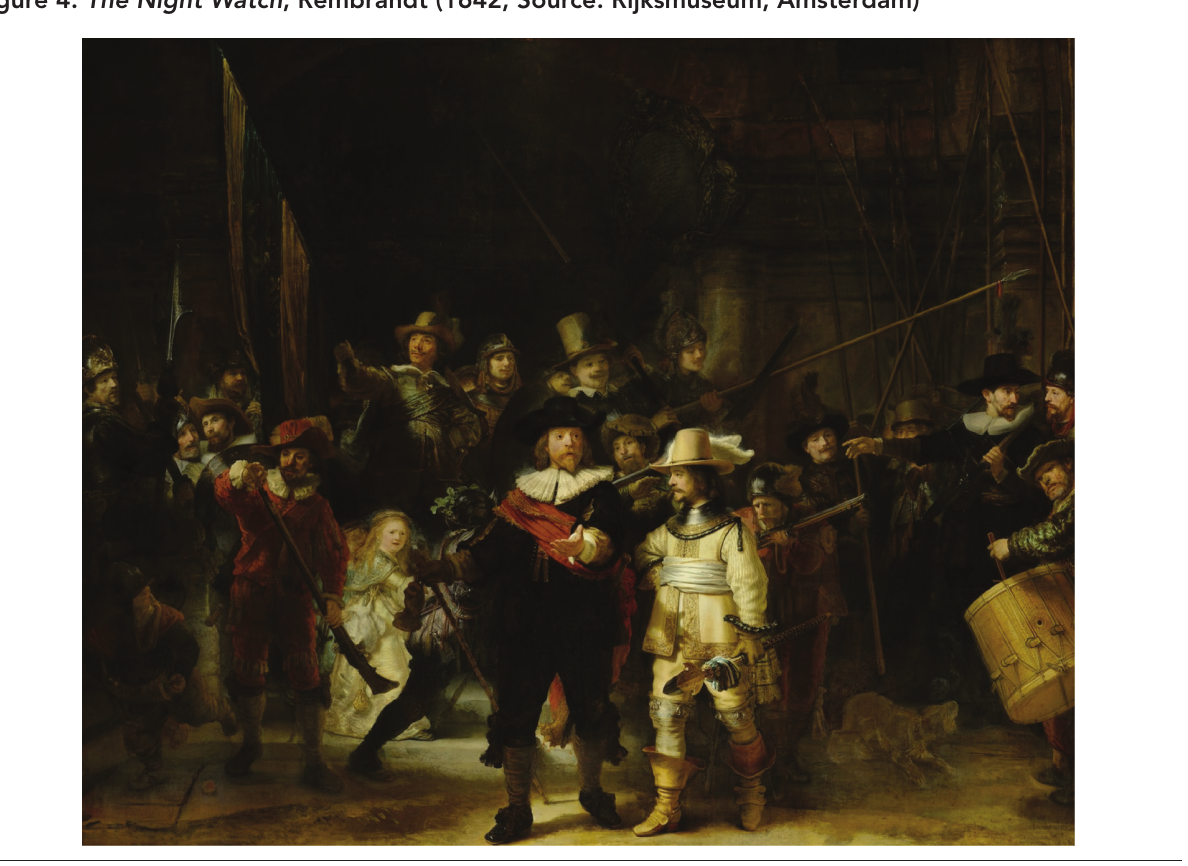
Figure 4. The Night Watch , Rembrandt (1642; Source: Rijksmuseum,